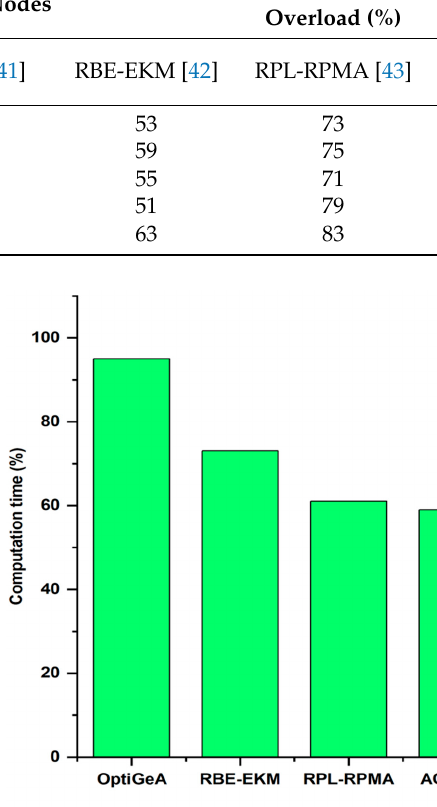
Figure 9. Computation time of the proposed and existing methods [41–45].